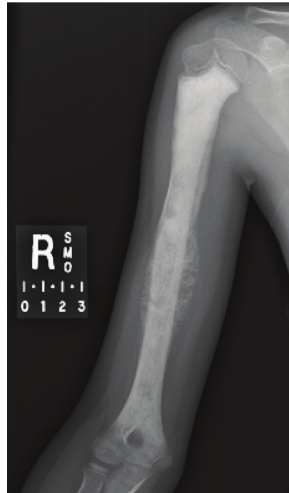
Figure 1: Anteroposterior radiograph of humerus following neoad- juvant chemotherapy for osteosarcoma.